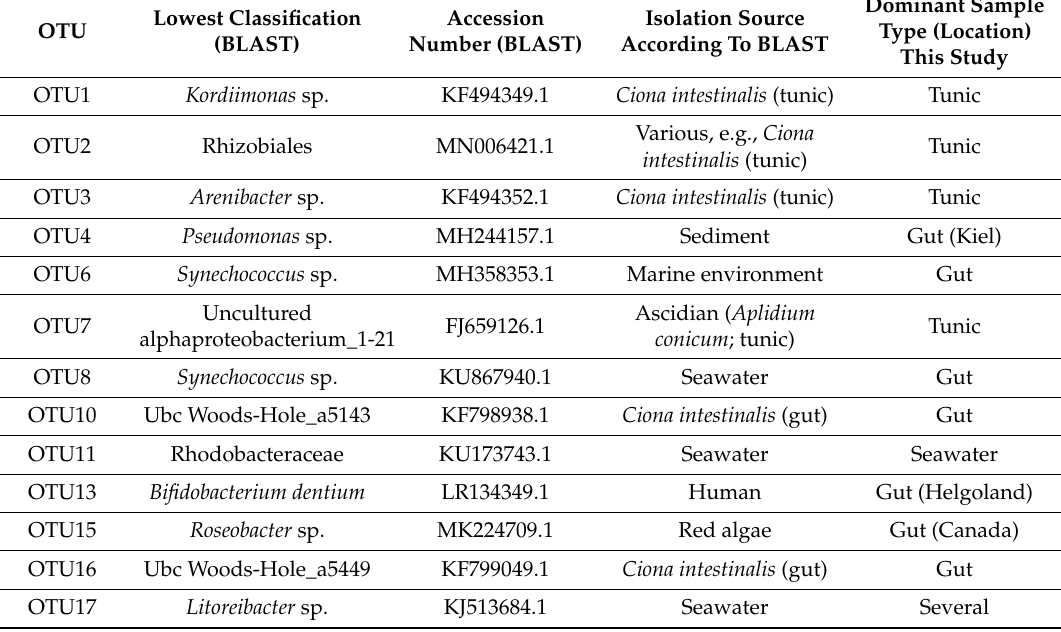
Table 1. Frequent bacterial OTUs ( ≥ 1%) with significantly di ff erent abundance across nine di ff erent sample groups (sample type and sampling location). The predominant sample type and (if applicable) sampling location (in brackets) in this study are indicated for each OTU. OTUs were classified with BLAST down to the lowest possible taxonomic rank and are given with the accession number and isolation source. Relative abundances, statistics, and full BLAST results are given in Tables S9 and S10. Ubc: Uncultured bacterium